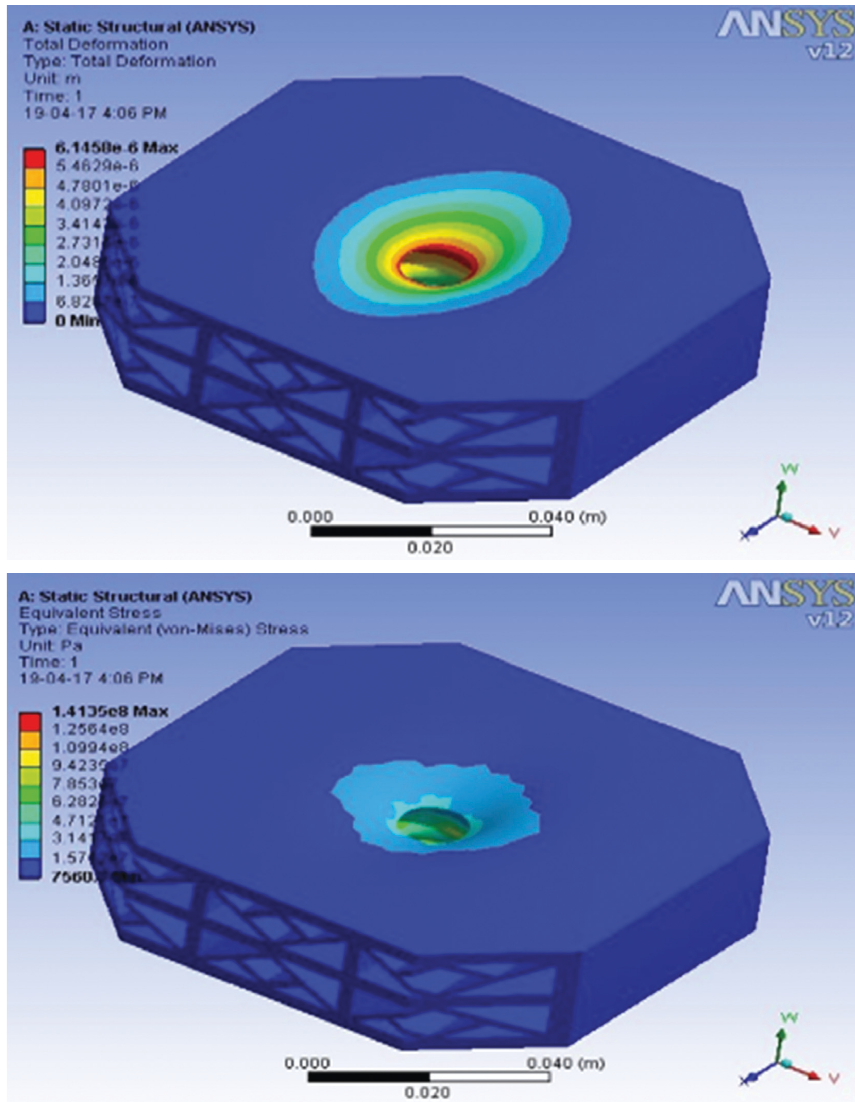
Figure 4: Developed compliant damper and its structural analysis report from